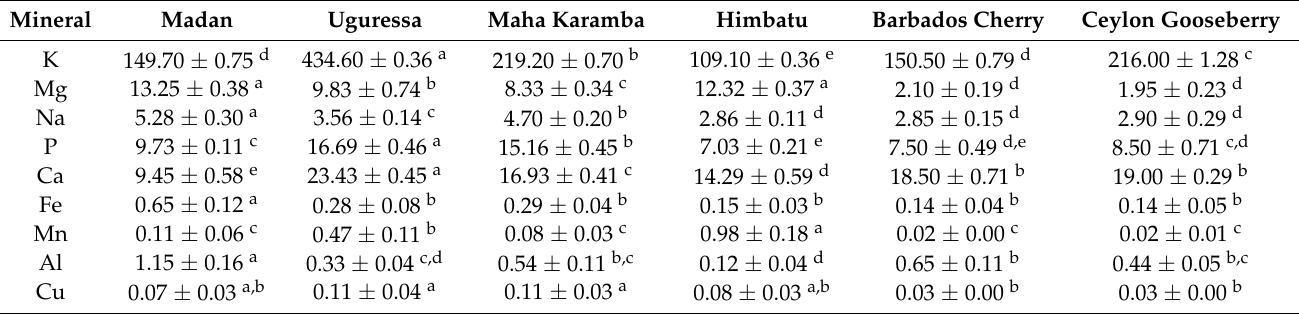
Table 4. Mineral content (mg/kg) of fruits